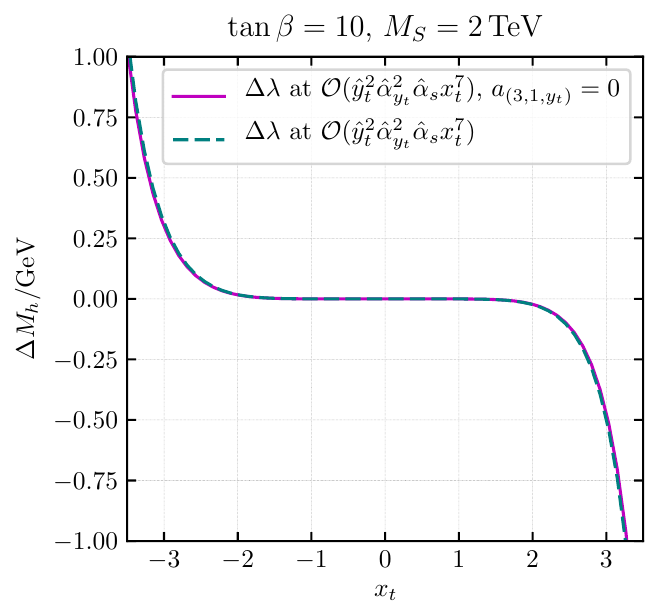
Figure 1 . Impact on the Higgs mass from 3-loop threshold correction ∆ λ from the highest power x t contribution at O (ˆ y 6 ˆ g 2 ) . The values of the Higgs mass are obtained by the calculation implemented t 3 in ref. [28] and its